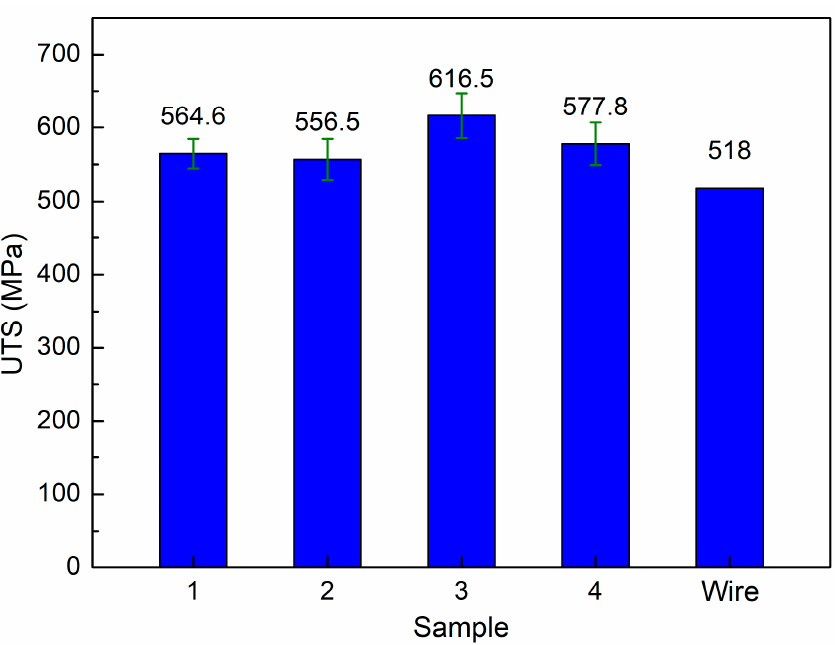
Figure 5. Average tensile strength of samples at di ff erent WAAM strategies.